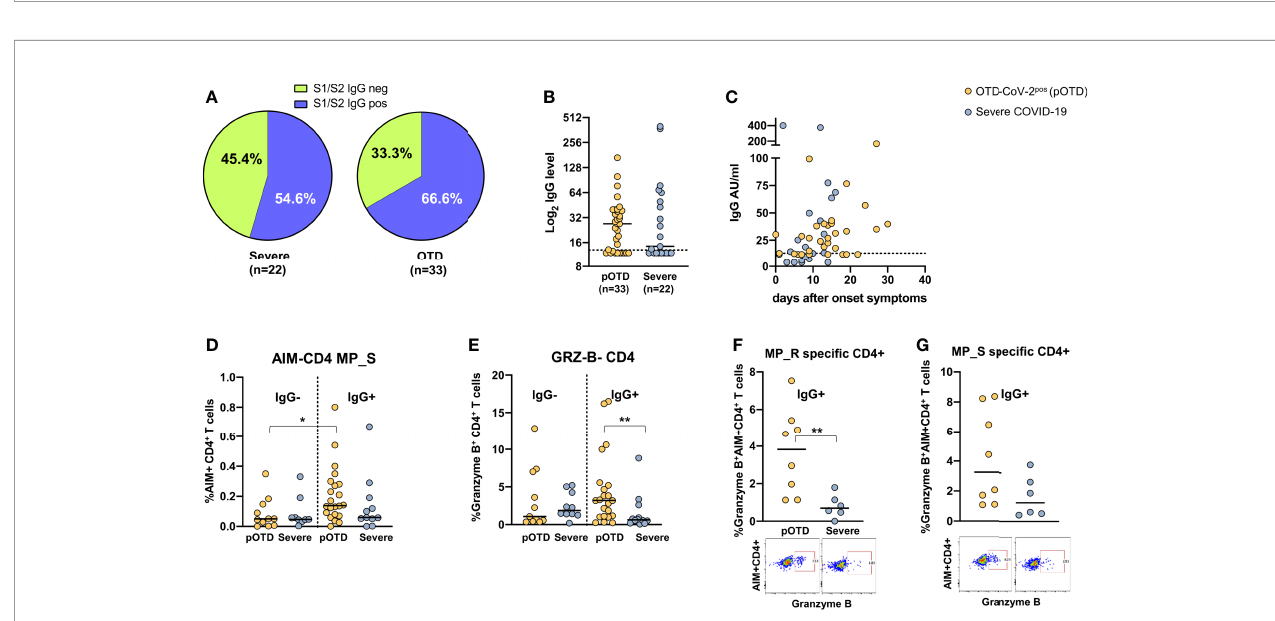
FIGURE 4 | Relationship between SARS-CoV-2 T cell and antibody responses in COVID-19 individuals. (A) Pie chart shows the percentage of positive (blue) and negative (green) S1/S2 IgG antibody subjects in OTD-CoV-2 pos and severe patient cohorts. (B) Distribution of serum S1/S2 IgG levels in seroconverted anosmic/ ageusic and severe COVID-19 individuals (IgG ≥ 13 AU/mL). (C) Association between time (days) from symptom onset and serum S1/S2 IgG levels. (D) Comparison of frequencies of AIM + CD4 + T cells in response to the MP_S peptide pool in IgG-positive and -negative patients in OTD-CoV-2 pos and severe COVID-19 groups. (E) Frequency of CD4 + T cells expressing granzyme B in OTD-CoV-2 pos and severe COVID-19 patients strati fi ed according to serum IgG positivity. (F, G) Frequency of AIM + CD4 T cells expressing granzyme B in IgG- positive OTD-CoV-2 pos and severe COVID-19 patients following stimulation with MP_R and MP_S respectively. Mann-Whitney U test was used to compare differences between two groups. Statistical comparison between four groups of subjects was assessed by the non- parametric. *p < 0.05; **p < 0.01.